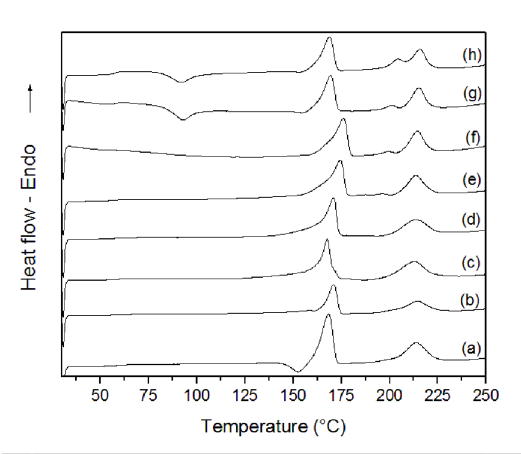
Figure 8. DSC heating curves of scPLA after isothermal crystallization at: (a) 90ºC, (b) 105ºC, (c) 120ºC, (d) 135ºC, (e) 150ºC, (f) 155ºC, (g) 160ºC and (h) 165ºC.